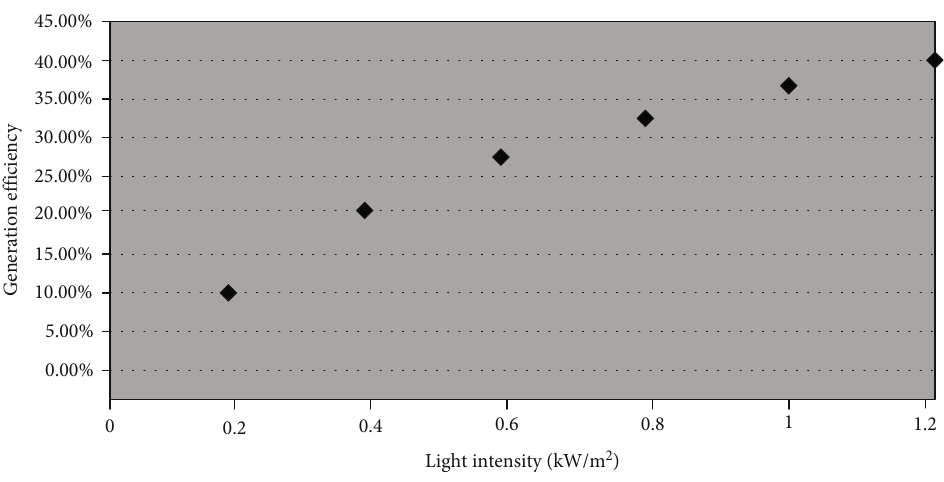
Figure 4: Power generation e ffi ciency of photovoltaic